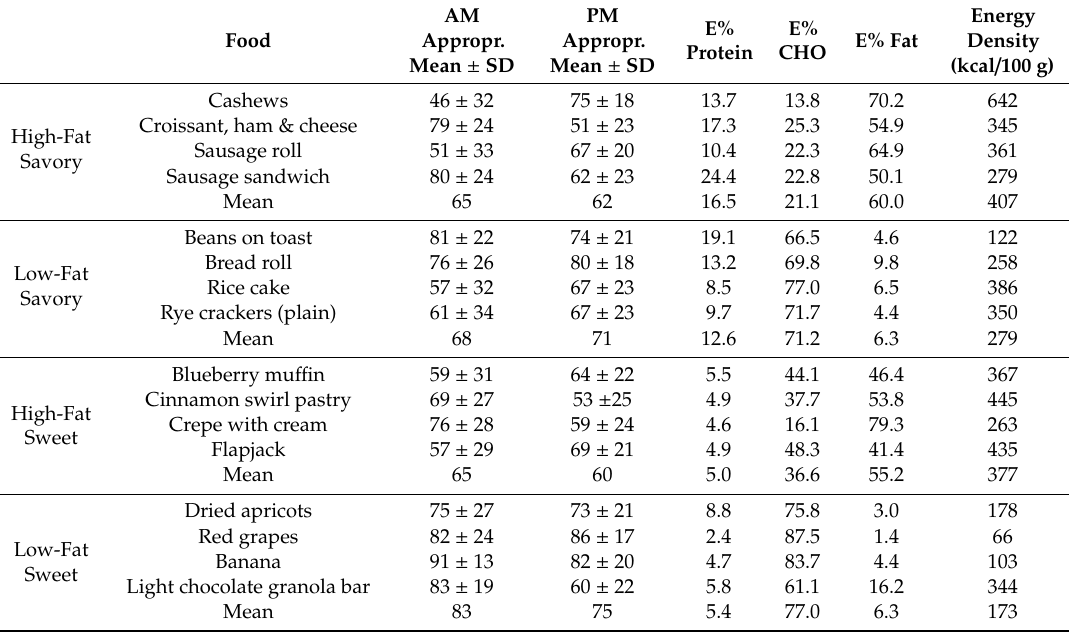
Table 1. Validation data of diurnal LFPQ food